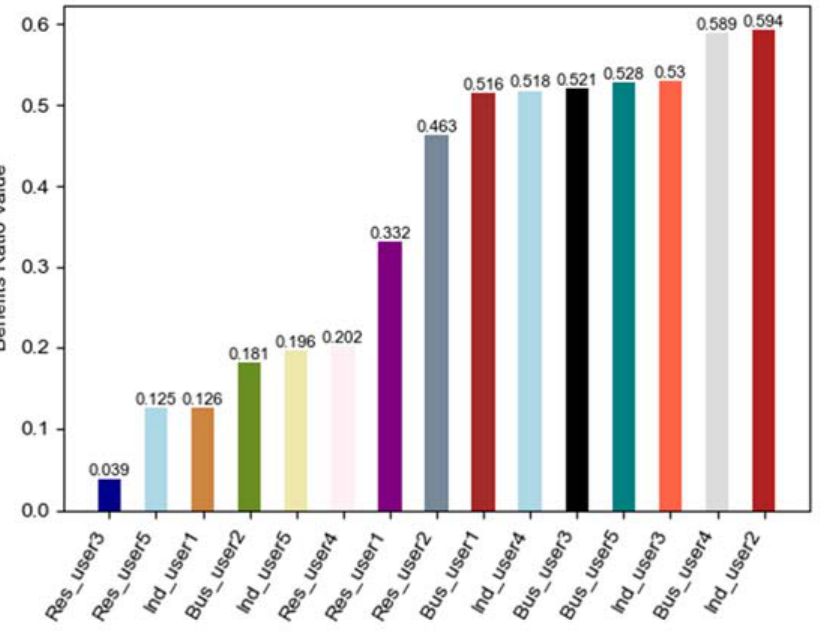
Figure 6. Ranking of the profit ratio value.